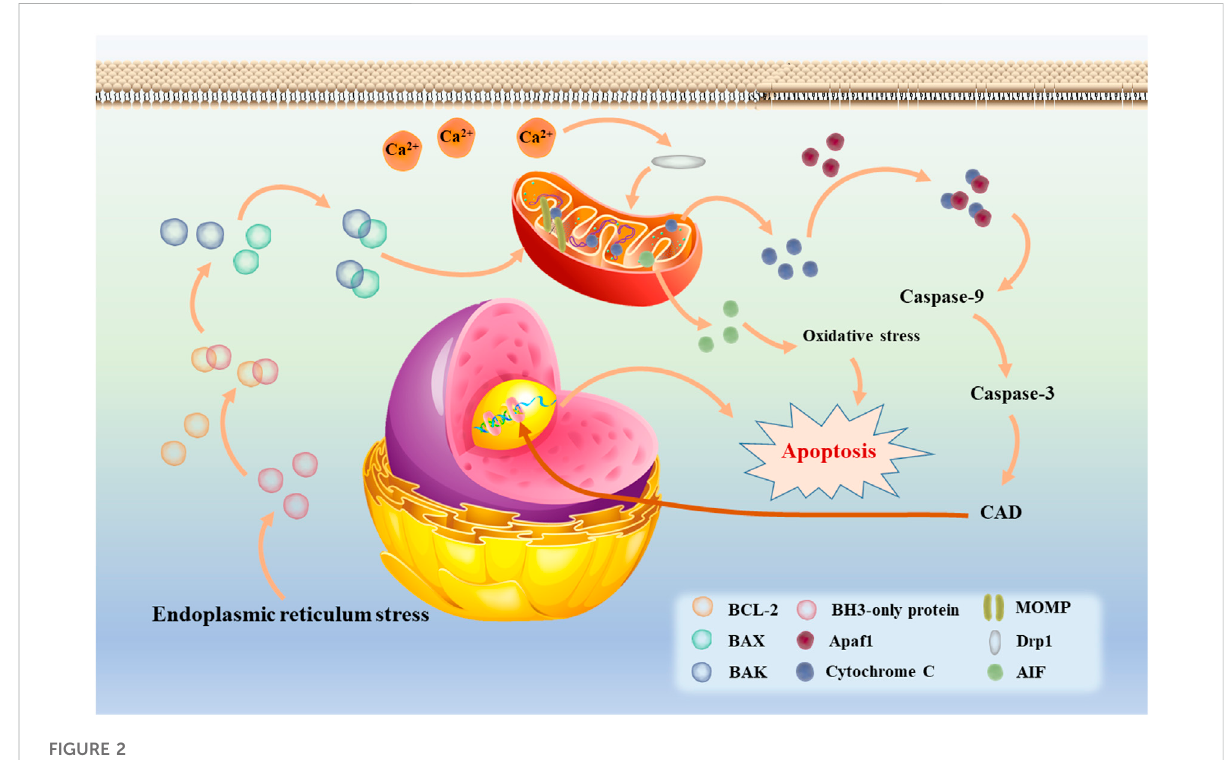
FIGURE 2 The intrinsic apoptotic mediated by mitochondria (also called Bcl-2 or mitochondrial